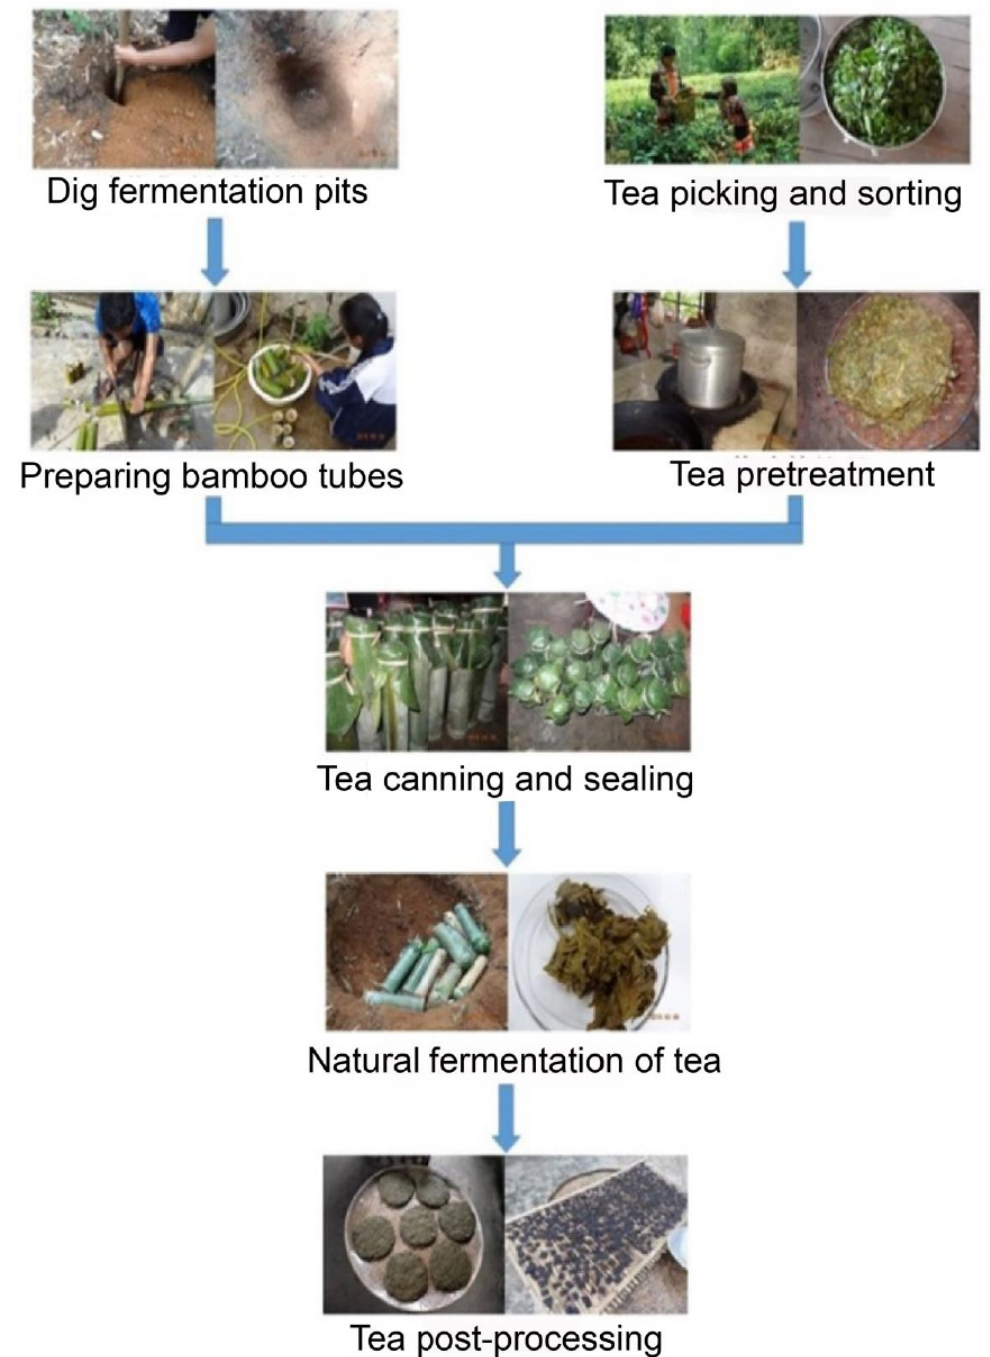
Figure 1. The sour tea fermentation process. Boiled fresh tea leaves are placed in a bamboo container. The bamboo pipe is sealed and buried three meters underground. The fermentation time of sour tea is 60 days, and then the sour tea is removed from the ground and fermented for 30 days. Pickled tea is produced by anaerobic microorganism fermentation. Traditional fer- mented tea is produced by fungal fermentation. For example, Rasamsonia , Thermomyces and Aspergillus are dominant fungi in the middle stage of the fermentation of Pu’er tea, while Aspergillus is the dominant bacteria in other stages [7]. One study found that most of the strains isolated from Miang were Latilactobacillus , among which Lactiplantibacillus plantarum ( Lb. plantarum ) was dominant (64.6%) [8]. Latilactobacillus and Acetobacter were the most abundant bacteria in Laphet. At the same time, Enterobacteriaceae bacteria